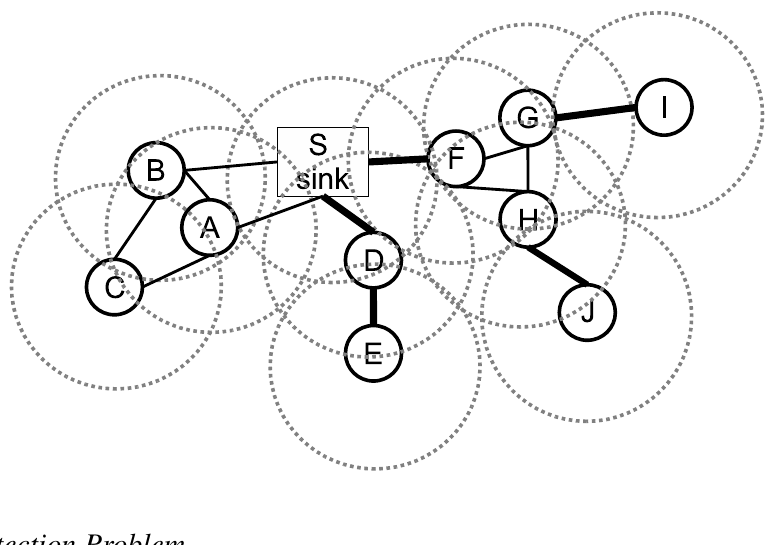
Figure 2. The graph model and the bridge